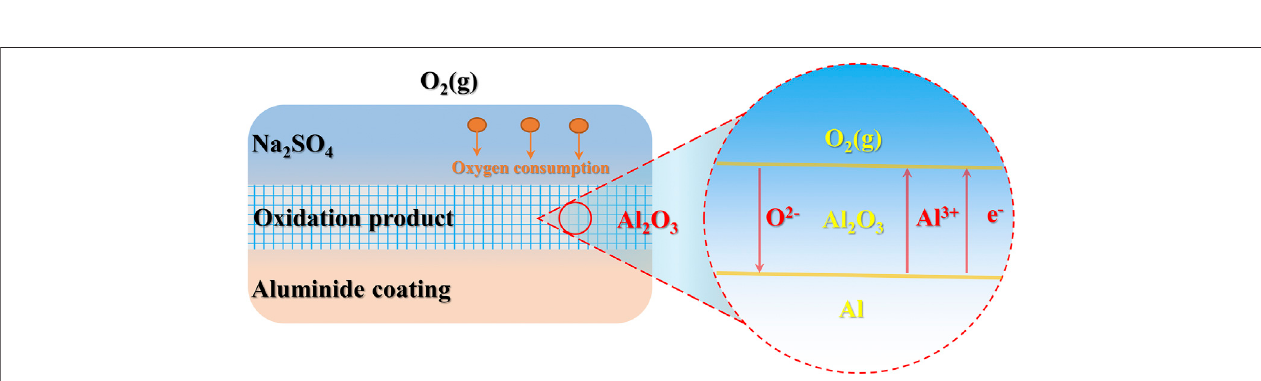
FIGURE 8 | Schematic diagram of aluminide coating oxygen consumption during the initial stage of hot corrosion.